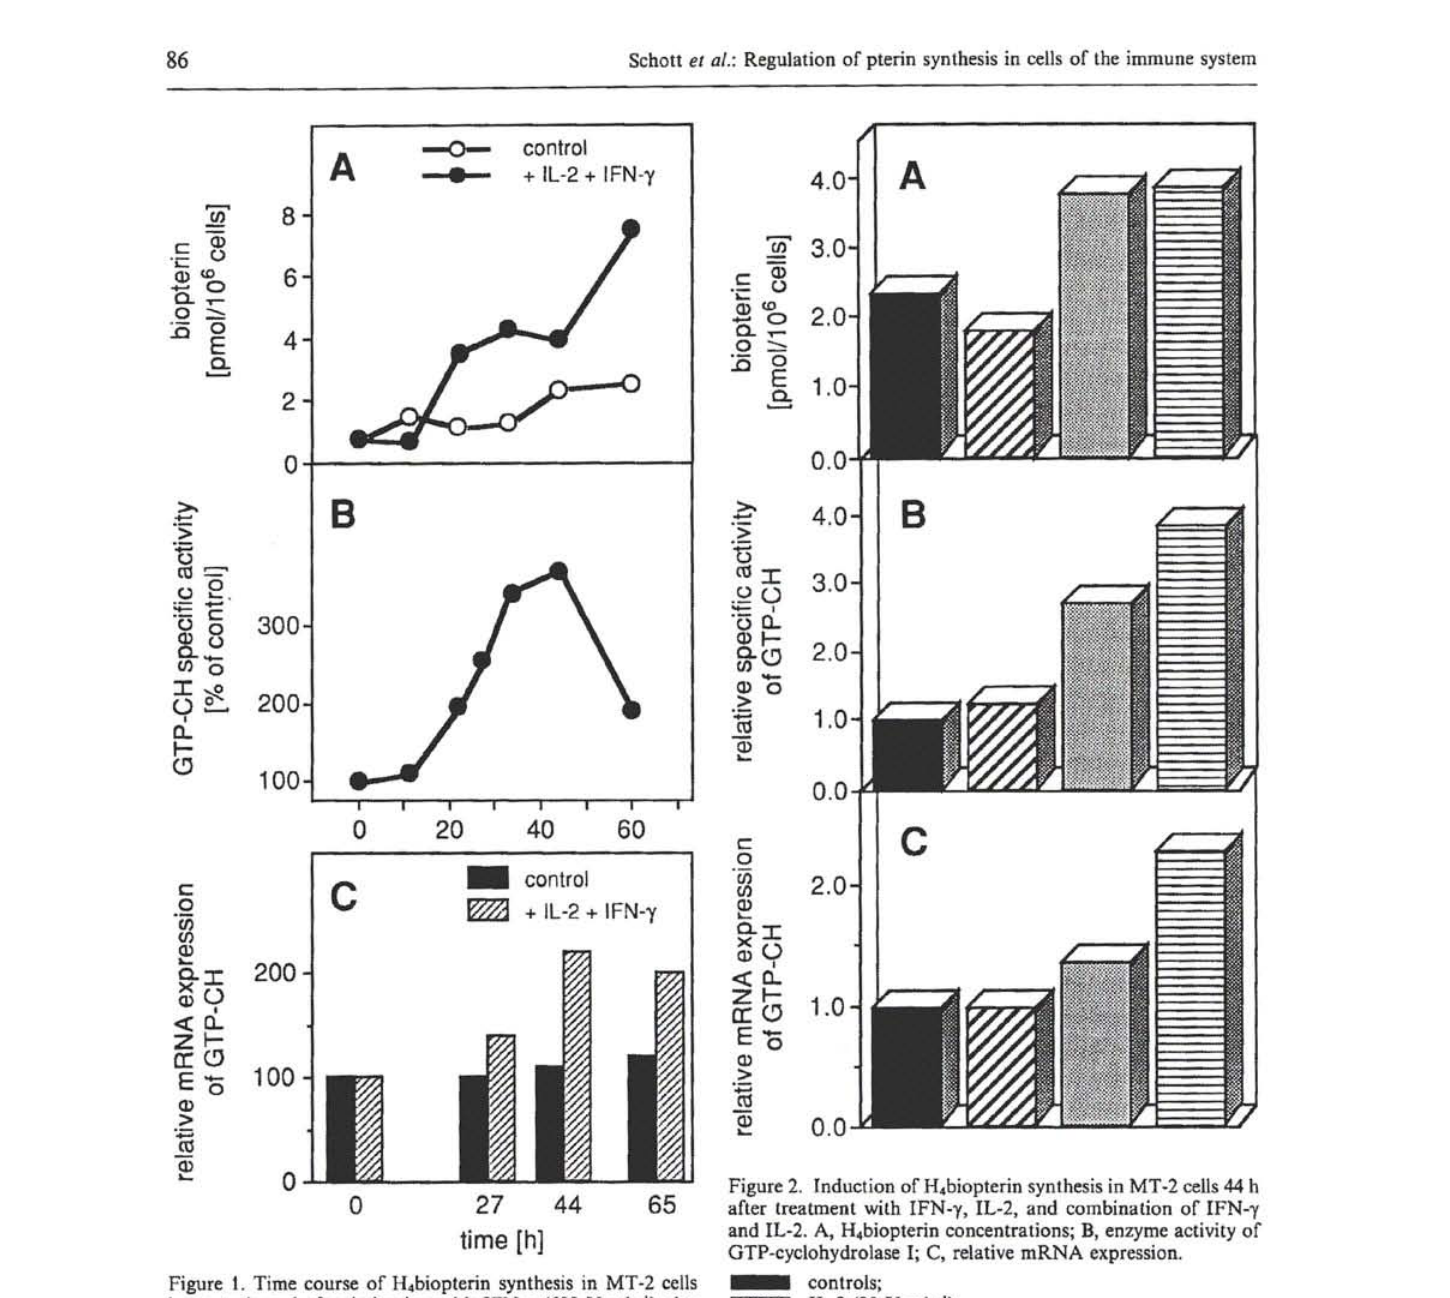
Figure 1. Time course of H 4 biopterin synthesis in MT-2 cells in controls and after induction with IFN-γ (500 U ml" 1 ) plus IL-2 (20 U ml"'). A, H 4 biopterin concentrations; B, enzyme activity of GTP-cyclohydrolase I; C, relative mRNA expression. Besides cytokines, also viral gene products induce pterin synthesis. In Burkitt lymphoma cell lines BL- 41, BL-40, and BL-30 neopterin levels amount to 4.1, 2.1, and 1.4 pmol neopterin/10 7 cells,